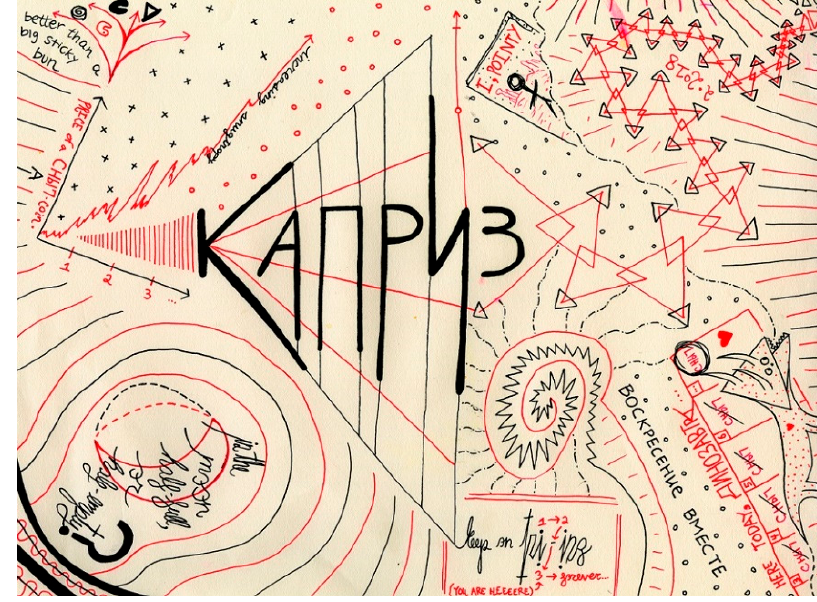
Figure A3. “ Каприз (Tantrum)”. Bilingual, narrative elements. Red and black pen, white paper.